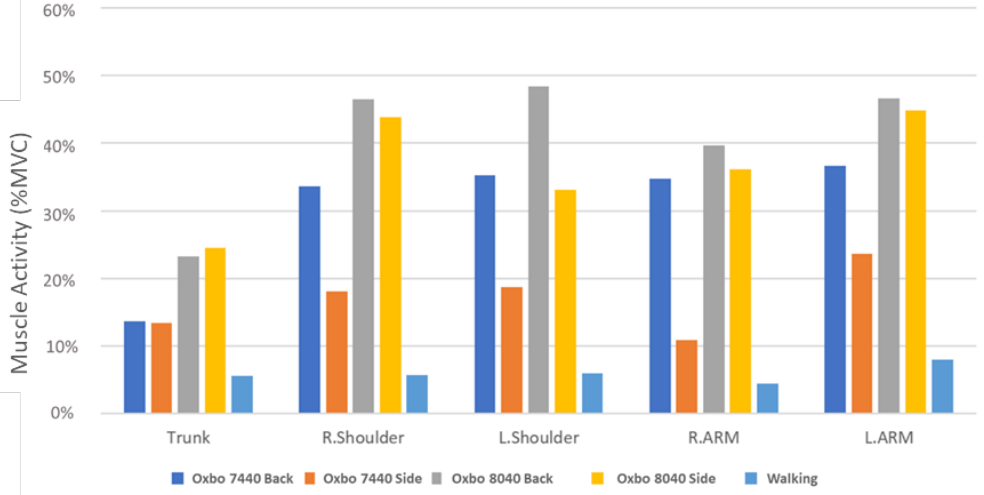
Figure 12. Muscle activity of five body regions by muscle (R.: Right; L.: Left).